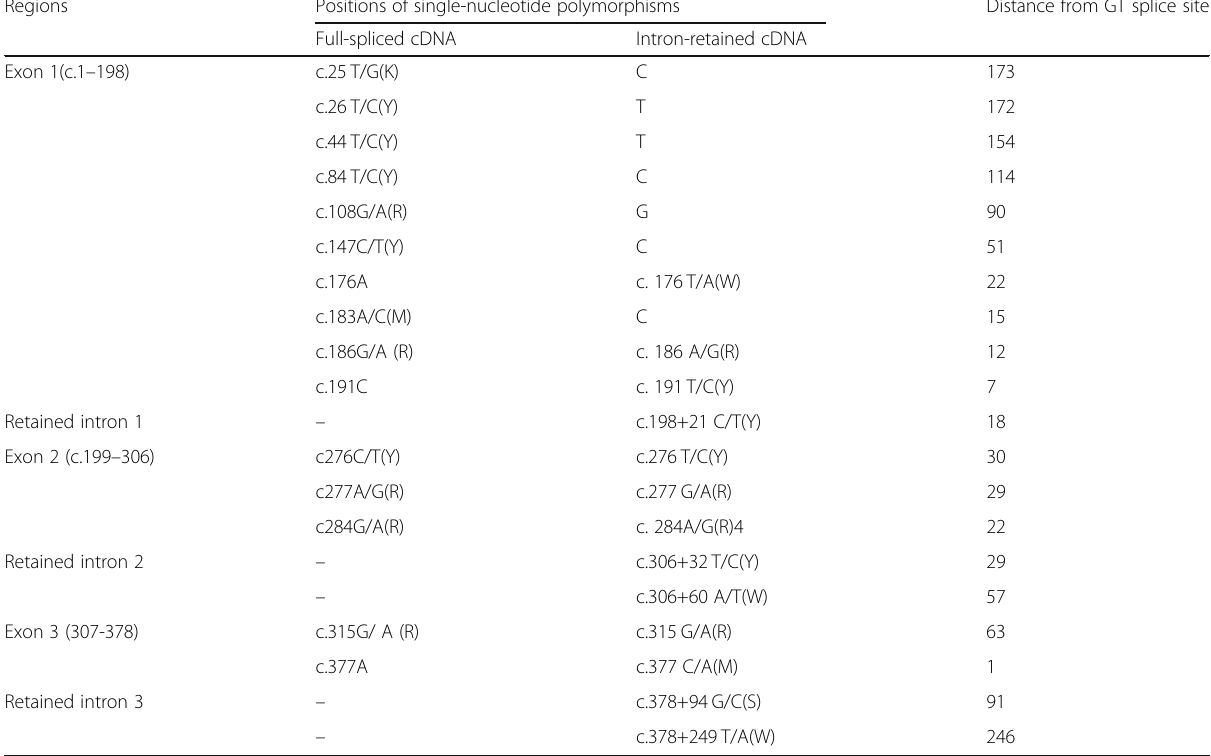
Table 4 Single-nucleotide polymorphisms in spliced and Intron-retained sequences of Egyptian buffalo CATH4 mRNA and their distances from GT splice site